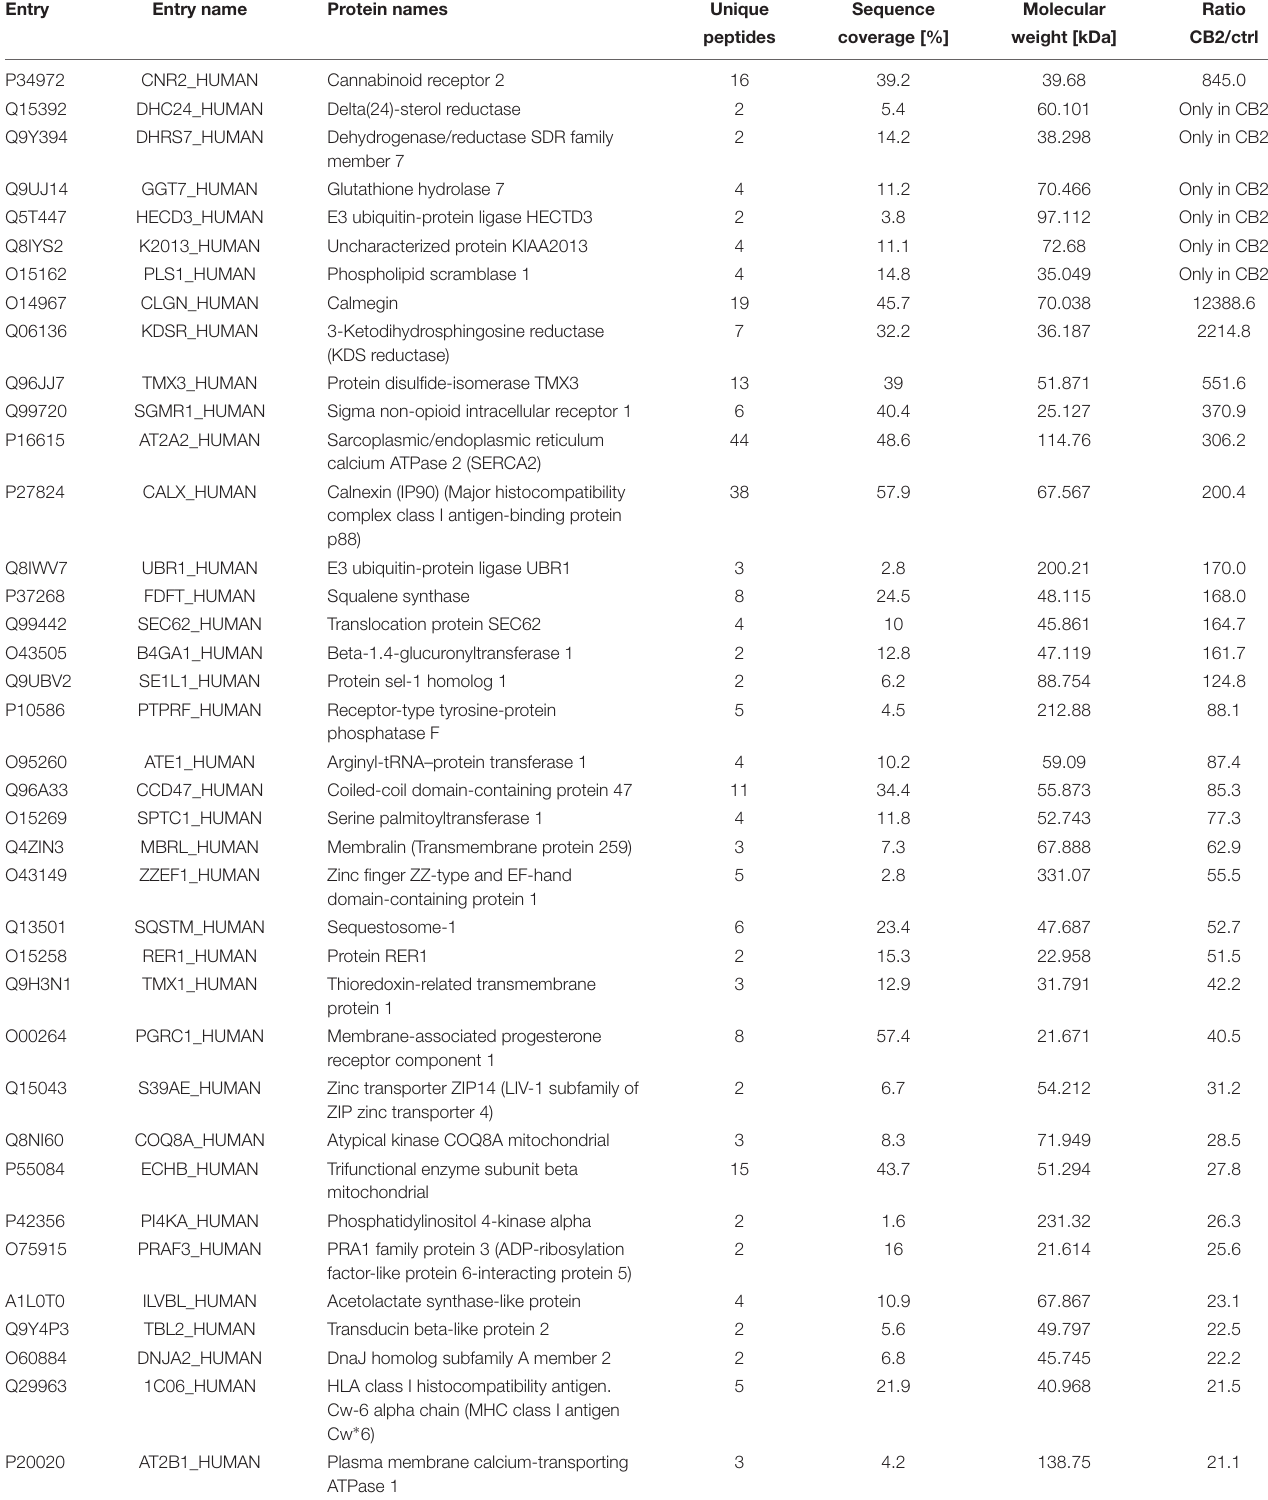
TABLE 2 | CB2 interactors in HEK293